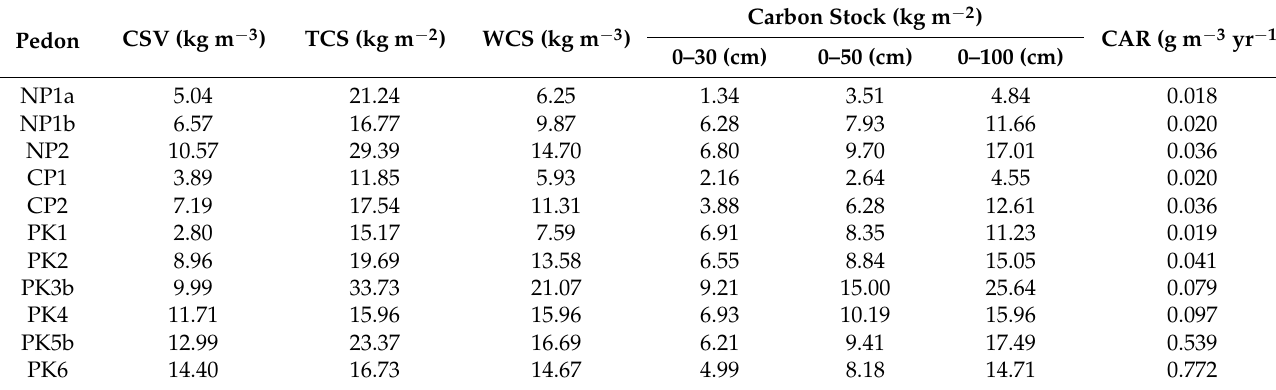
Table 2. Pakua tableland carbon stock calculation and estimation values for each pedon. Pedon